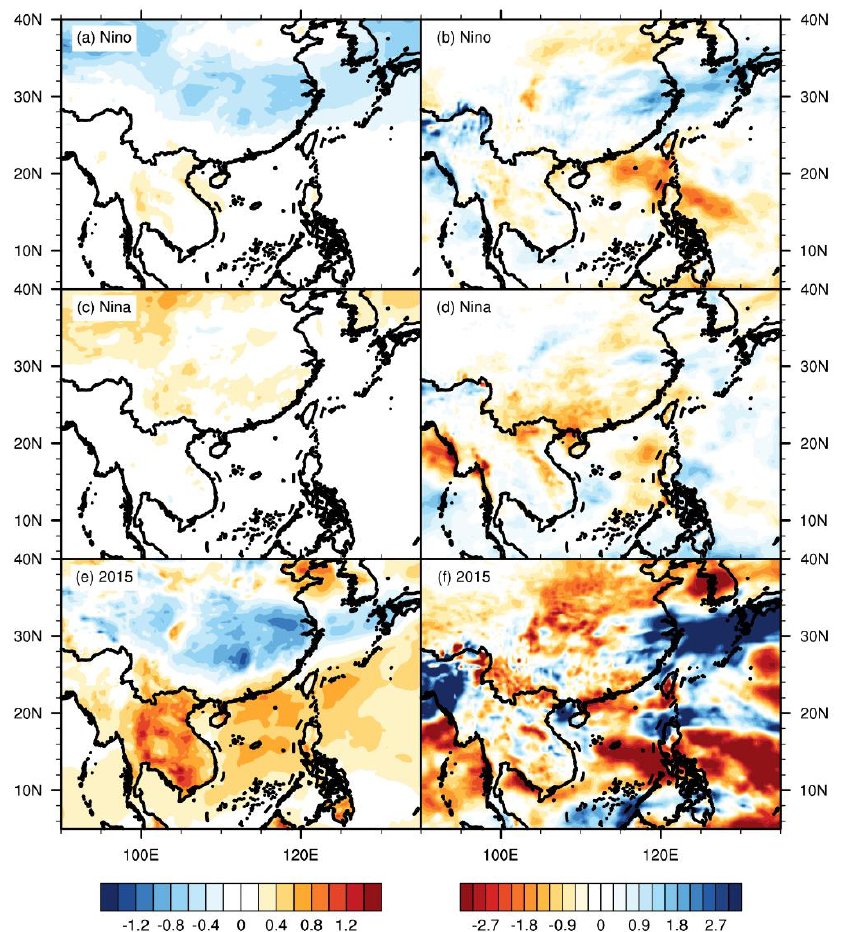
Figure 4. Average temperature at 2m (left; unit: K) and precipitation rate (right; unit: mm/day) anomalies of JJA in ( a , b ) El Niño years, ( c , d ) La Nina years, and ( e , f ) 2015 from ERA5 reanalysis datasets.